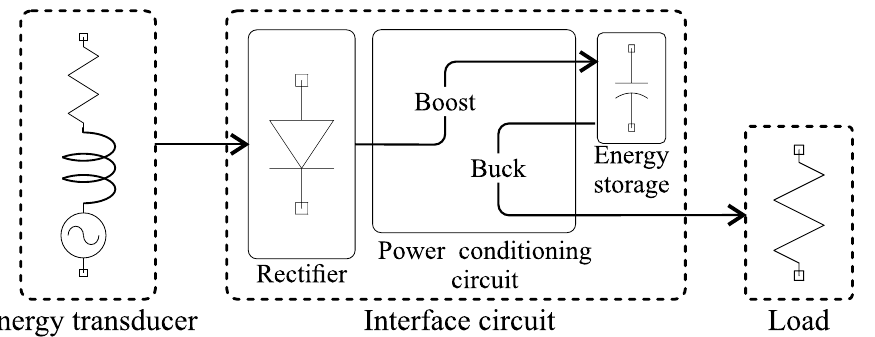
Figure 1. Overview of the Variable Reluctance Energy Harvesting system under